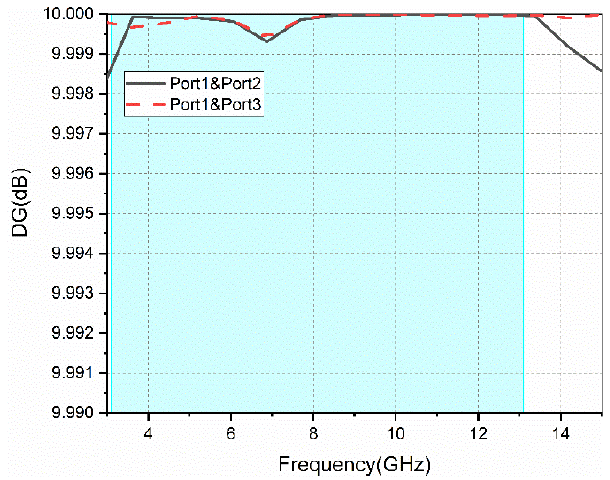
Figure 12. Diversity gain between different ports.